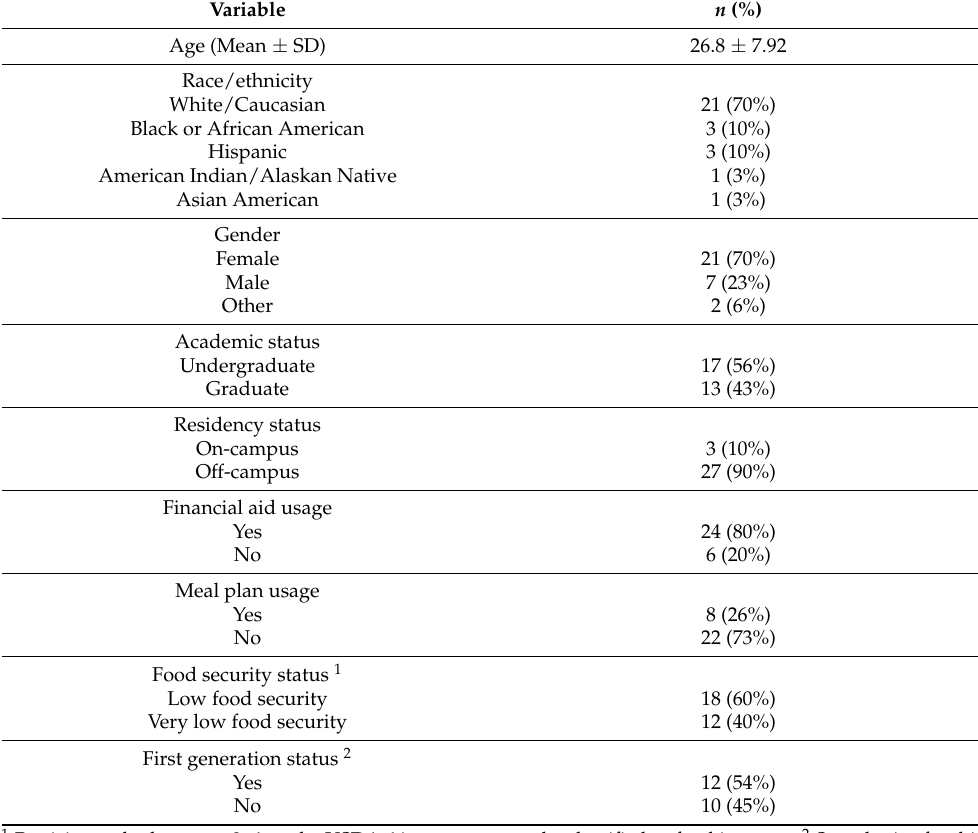
Table 1. Demographic characteristics of student participants ( n =